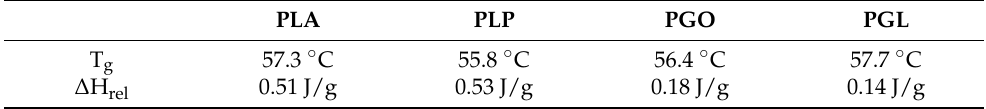
Table 9. T g and ∆ H rel for PLA, PLP, PGO, and PGL.